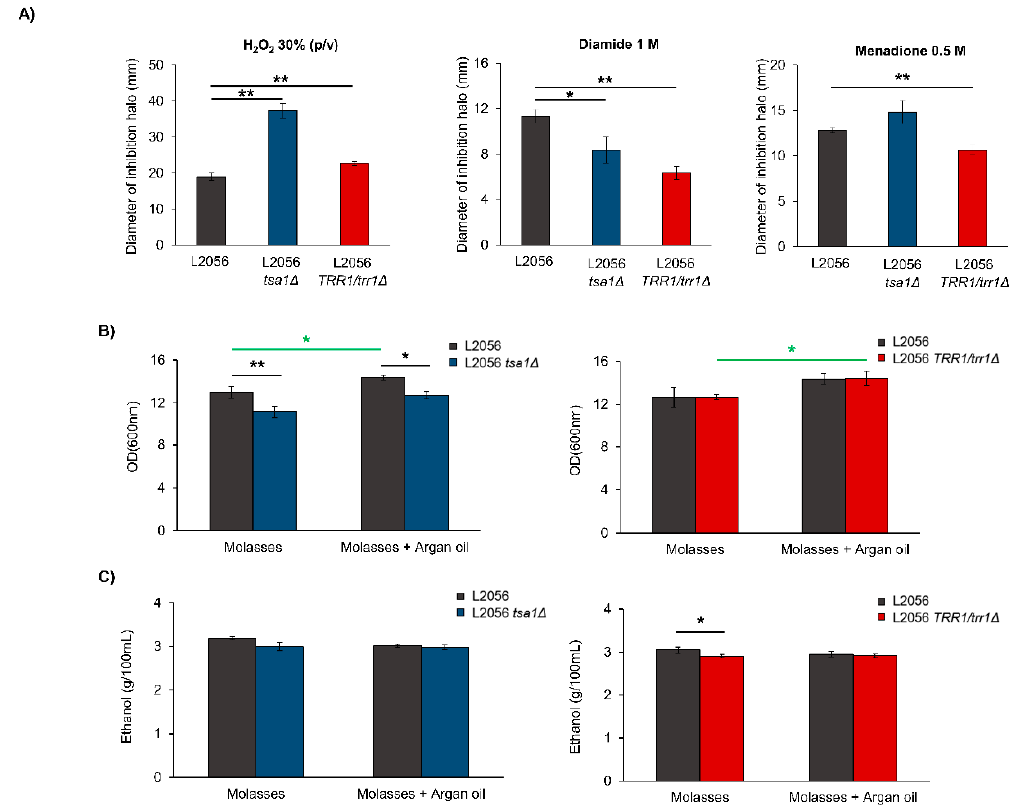
Figure 2. The tsa1 ∆ mutant phenotype. ( A ) Oxidative stress analysis of the L2056 tsa1 ∆ and L2056 trr1 ∆ / TRR1 mutants. The diameter of the inhibition halo caused by the indicated amount of oxidant molecule is shown. ( B ) Growth measured by OD600 of the wild type, L2056 tsa1 ∆ and L2056 trr1 ∆ / TRR1 mutants after 24 h in flasks with molasses, with and without argan oil 12 µ L / mL. ( C ) Ethanol produced during the described experiment. Experiments were carried out in triplicate. The mean and standard deviation are shown (* p < 0.05; ** p < 0.01, Student’s t test).